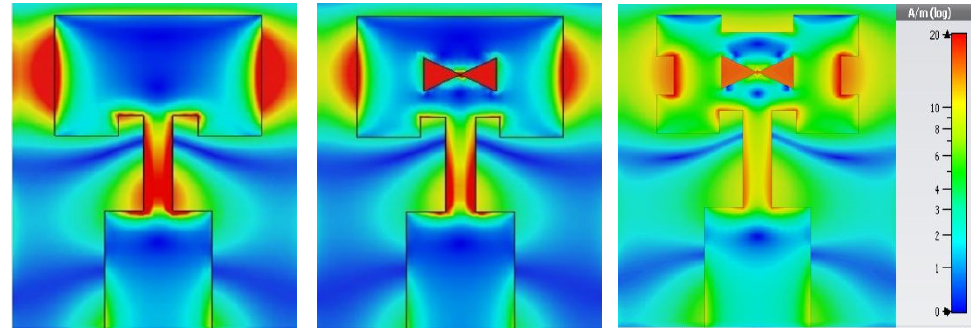
Figure 3. Surface current distribution at 28 GHz for each design stage of the single antenna. Parametric Analysis